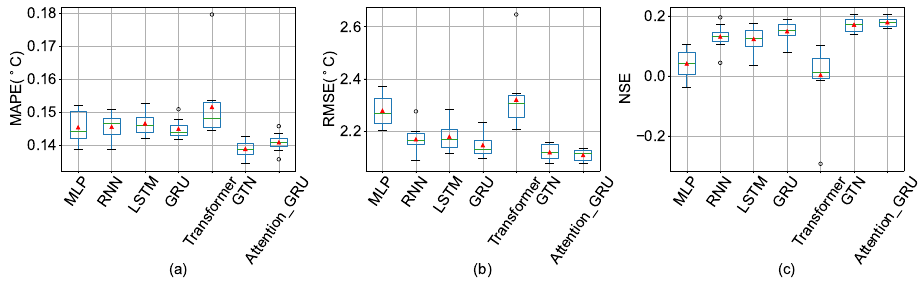
Figure A3. The box plot of ten experiment results of deep learning models under the Multivariate regression. ( a ): The results of MAPE. ( b ): The results of RMSE. ( c ): The results of NSE.